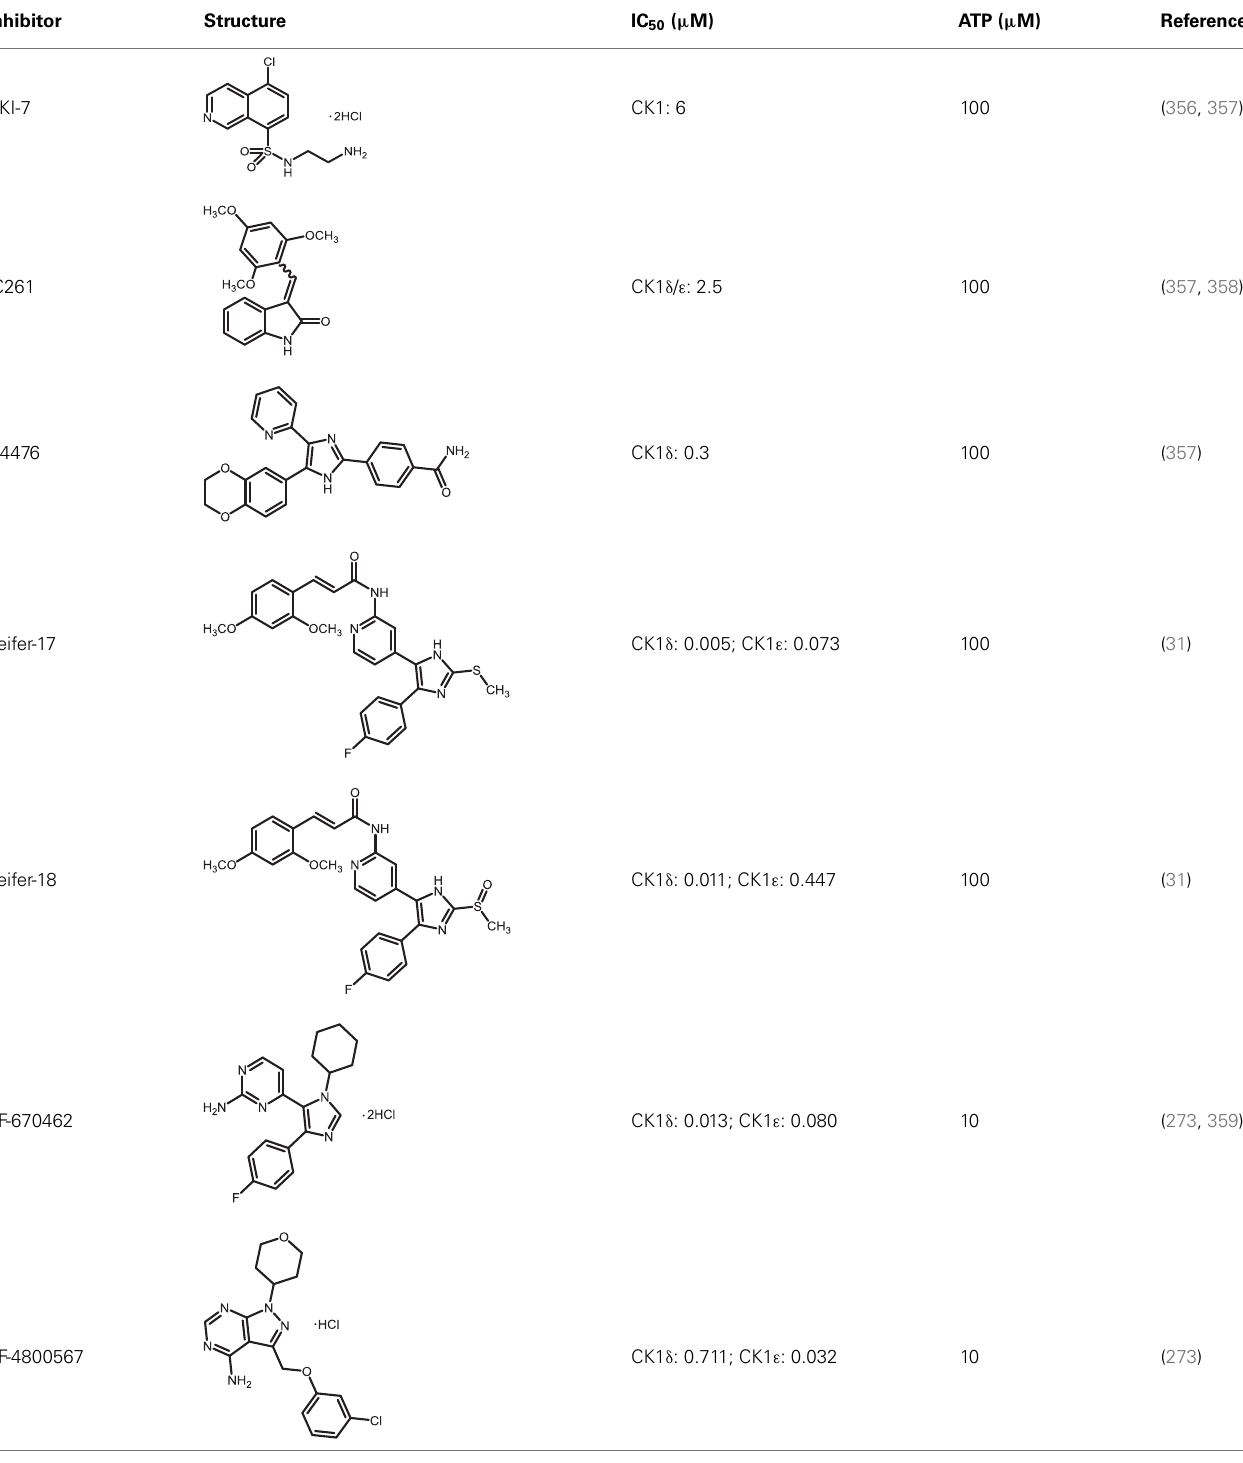
Table 3 | CK1-specific small molecule inhibitors . Inhibitor